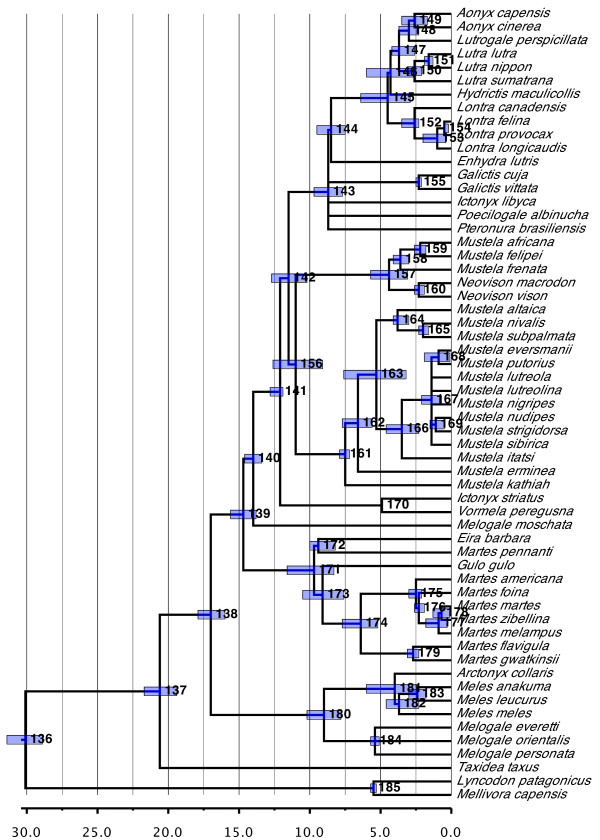
Phylogenetic relationships and divergence times estimates within Mustelidae. Nodes are individually numbered, with node bars indicating 95% confidence intervals on the divergence time estimates (in Ma before present).